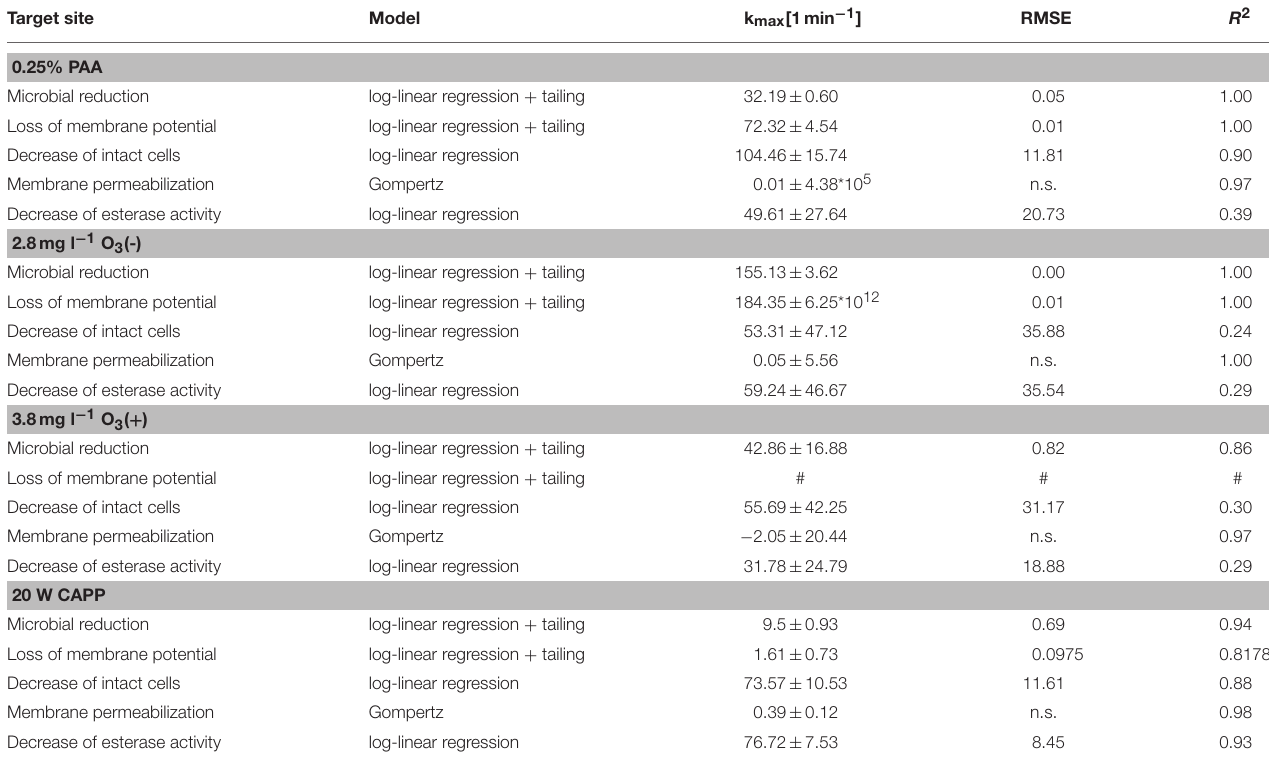
TABLE 5 | Statistical measures and parameter values obtained from GInaFit Version 1.6 and SigmaPlot13 for experimental data of inactivated P.